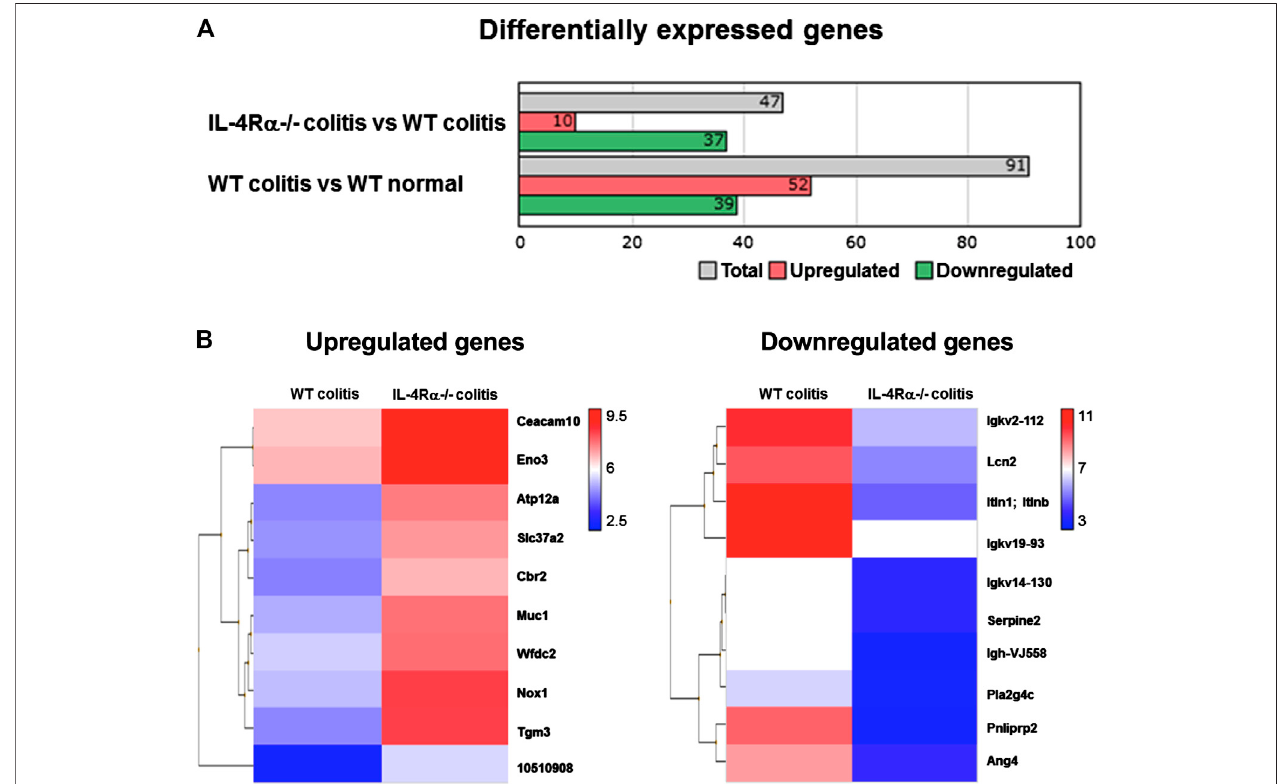
FIGURE4| TranscriptomicanalysisshowsthatIL-4R α -/-miceexhibitahighlevelof Nox1 mRNAexpression inDSS-inducedcolitismodel. Microarray datasetsof WT normal, WT colitis (day 7) and IL-4R α -/- colitis (day 7) mice are analyzed using Transcriptomic Analysis Console (TAC) Software. (A) Differentially expressed genes whose expression levels are more than four-fold or less than quarter in comparison between IL-4R α -/- colitis and WT colitis or WT colitis and WT normal. (B) Heat map showstop10upregulated(left)anddownregulated(right)inIL-4R α -/-colitismicecomparedwithWTcolitismice.Thecolorrangerepresentslog2-transformedfold changes. Each row corresponds to each gene, and each column corresponds to each group. Genes were sorted using hierarchical clustering based on Euclidean distance and average linkage, as shown in the dendrogram on the left side of the heatmap. The 10 gene names are displayed on the right side of the heatmap.